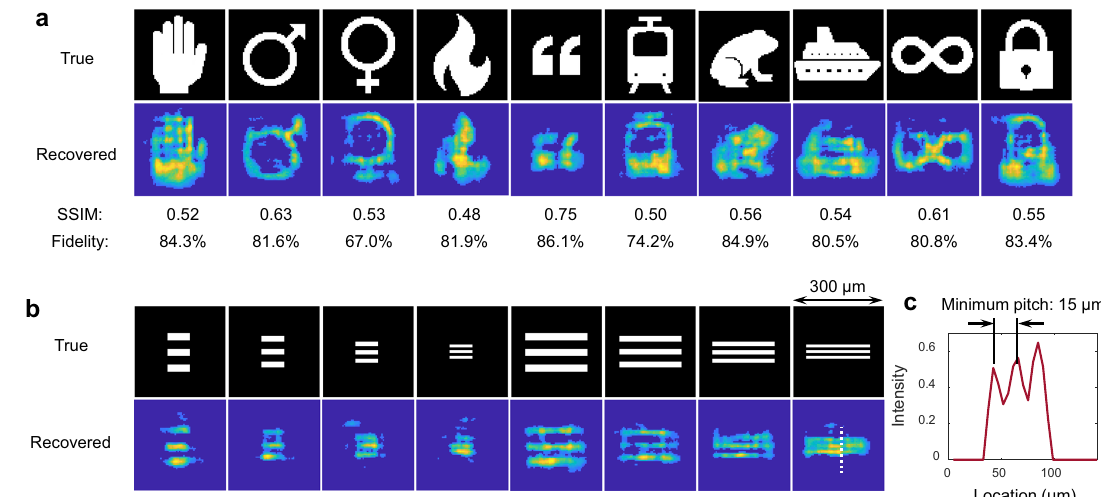
Fig. 5 Imaging of random types of objects. a Several recovered images of different types. b Recovering results of images containing resolution targets similar to the USAF 1951. The width of the images displayed on the DMD is approximately 300 μ m. c Vertical intensity pro fi le of the smallest recovered bars along the white dotted line in ( b ). The pitch of 15 μ m can be